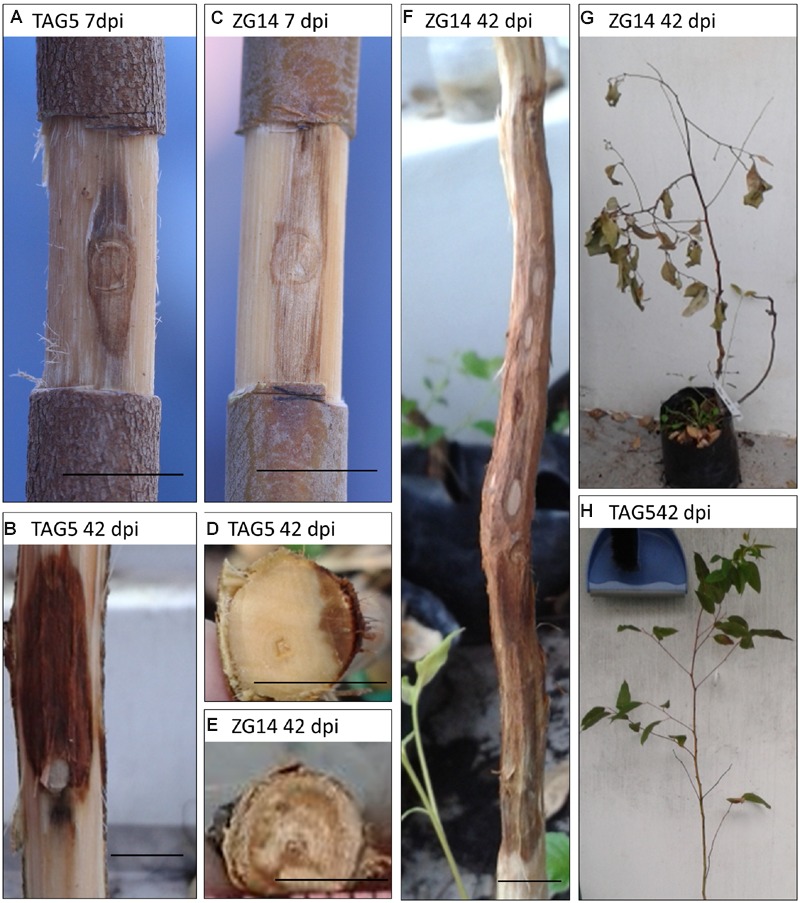
Lesion development in Eucalyptus grandis clones inoculated with C. austroafricana. Lesions in TAG5 (A,B,D) and ZG14 (C,E,F) at 7 dpi and 42 dpi are shown. Different rates of radial lesion development (D,E) were observed, and wilting occurred in some ZG14 plants by 42 dpi, while TAG5 leaves remained healthy (G,H). Scale bars indicate 10 mm in all images except (E), which indicates 5 mm.